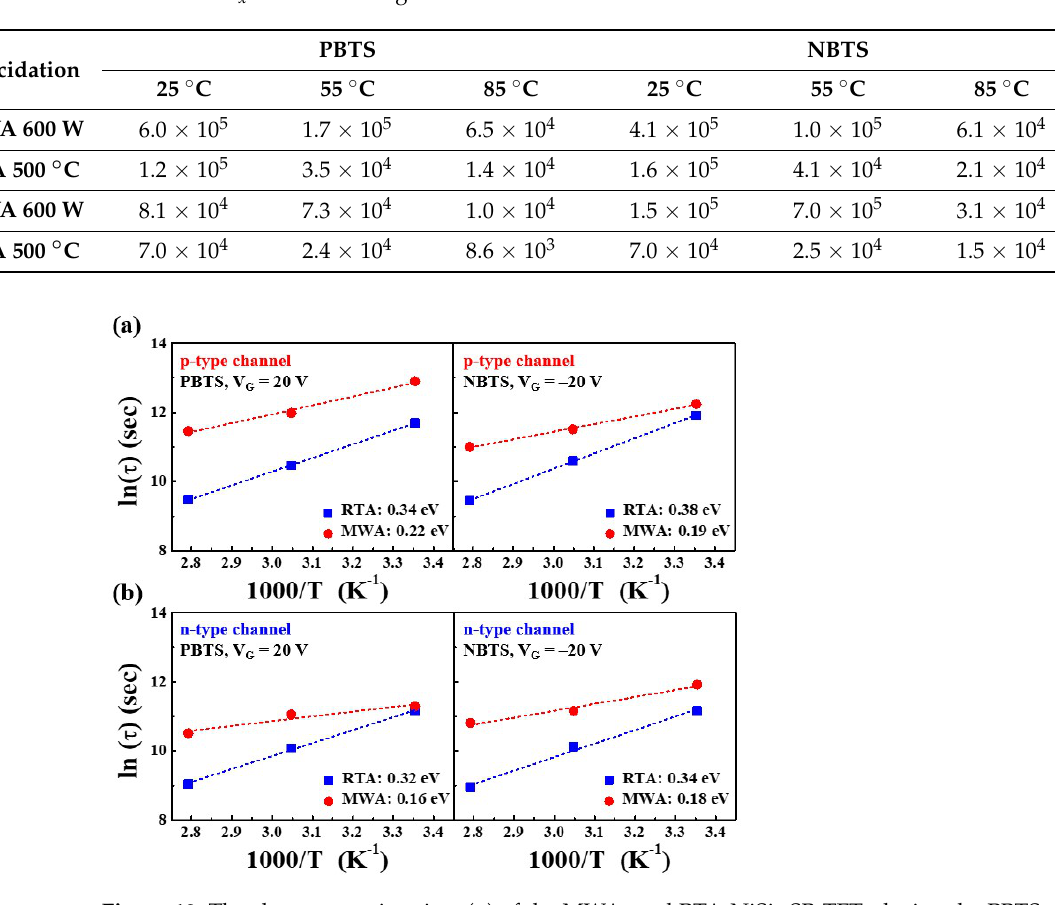
Figure 9. Box plots of the charge trapping time (τ) in the p-channel (a) and n-channel (b) behavioral modes of the MWA- and RTA-NiSi x SB-TFTs during the PBTS and NBTS tests. Table 3. The charge trapping time (τ) extracted from the temperature-dependent ΔV TH of the MWA and RTA NiSi x SB-TFTs during the PBTS and NBTS tests.